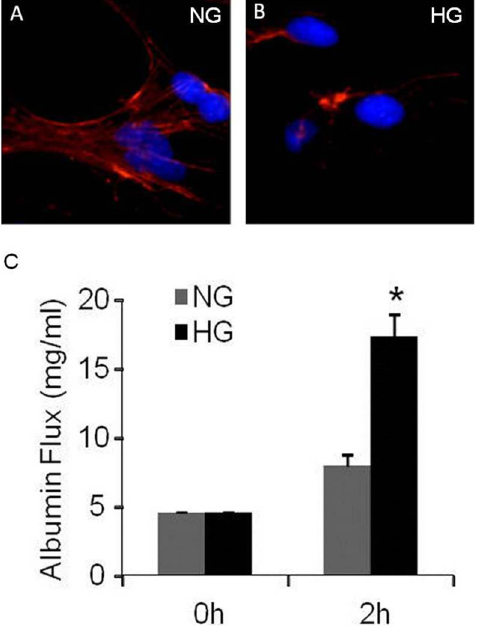
Figure 3. Effect of high glucose on structure and function injury in podocytes. A and B Immunofluorescence staining of F-actin showed in red, DAPI showed in blue (n=5); C. Analysis of the albumin flux across podocytes monolayer (n=5). Normal glucose, 5 mM D- glucose (NG); high glucose, 25 mM D-glucose (HG). Data presented as mean 6 SEM, * p , 0.05 vs NG